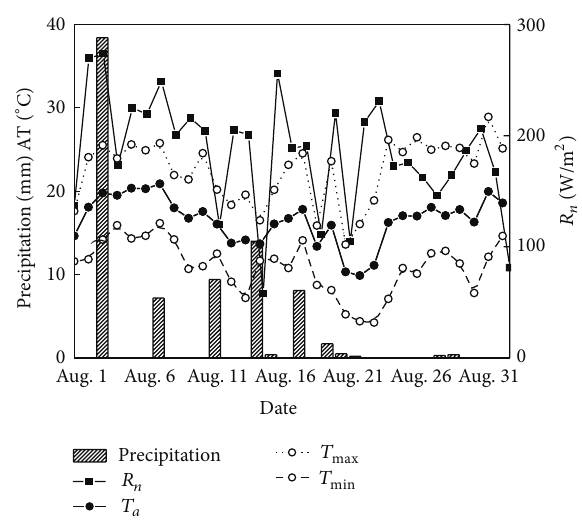
Figure 2: Daily precipitation, air temperature ( 𝑇 𝑎 , daily mean; 𝑇 𝑇 max , daily maximum; min , daily minimum) and net radiation ( during the experimental period from 1 August to 31 August 2012 in a typical temperate steppe at Xilinhot, Inner